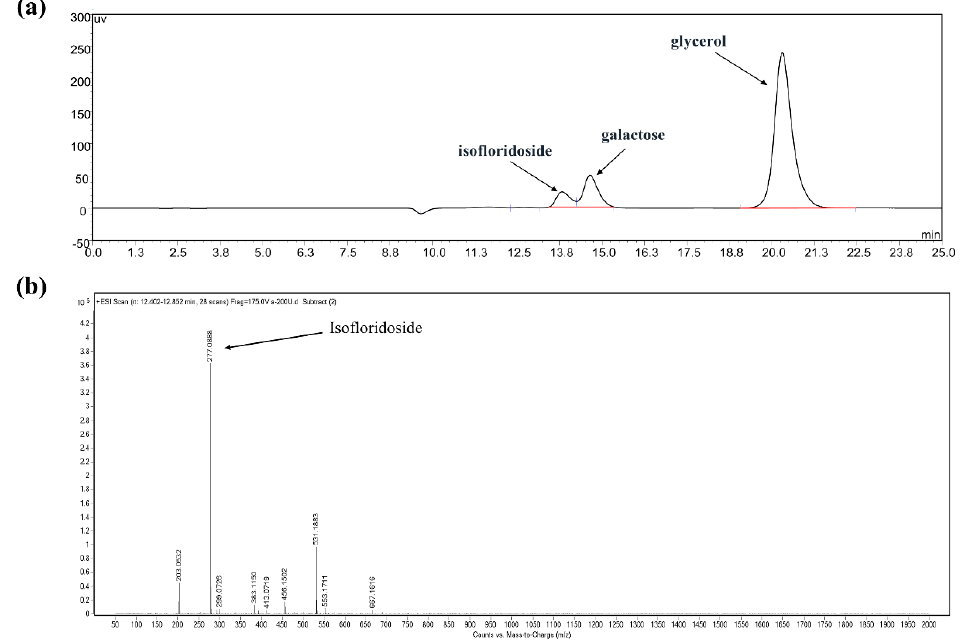
Figure 8. ( a ) HPLC analysis of the reaction mixture from reverse hydrolysis catalyzed by galV. ( b ) LC − MS spectra of the reaction mixture from reverse hydrolysis catalyzed by galV.